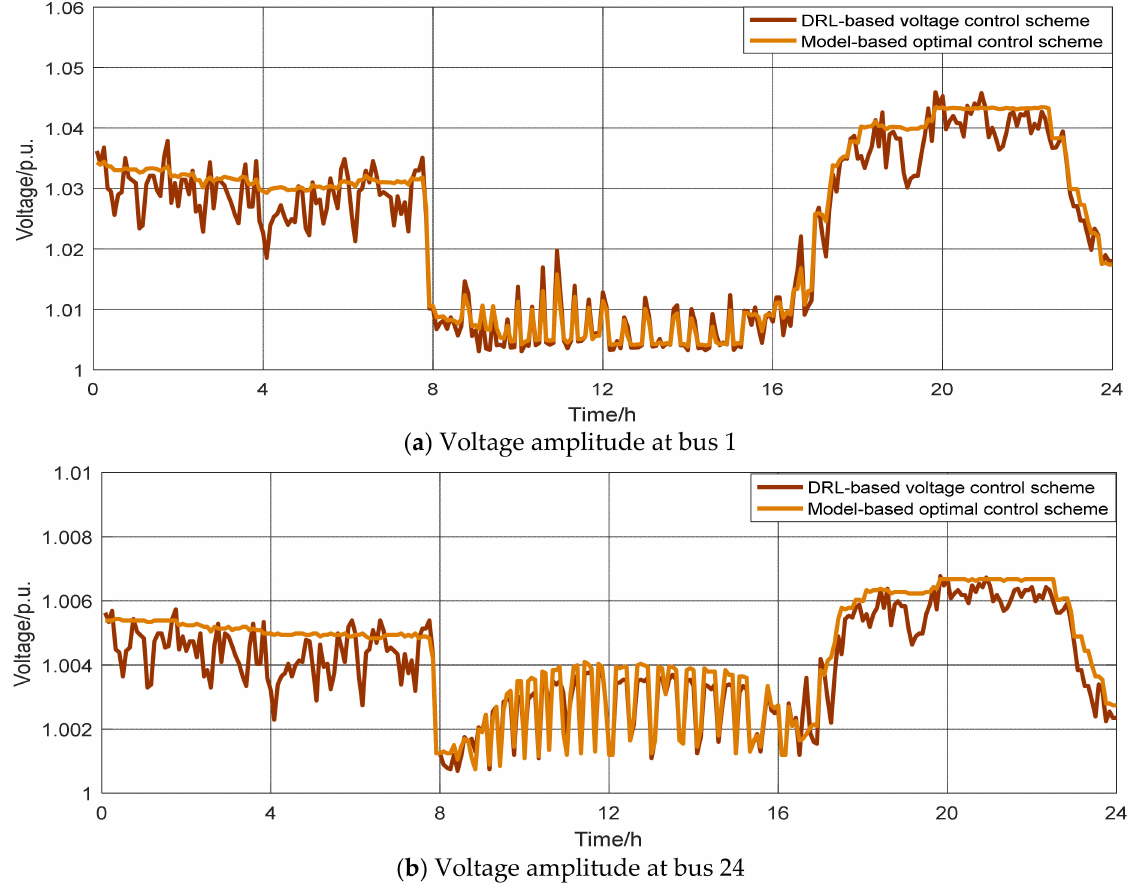
Figure 8. Voltage profiles under different methods on a cloudy day. ( a ) Voltage amplitude at bus 1, ( b ) Voltage amplitude at bus